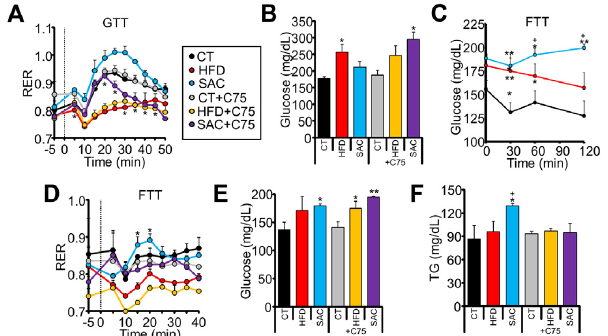
Figure 3. SAC mice rely on de novo lipogenesis (DNL) to maintain glucose homeostasis. ( A ) Oral administration of glucose increased respiratory exchange ratio (RER) in CT but not HFD mice, as measured by indirect calorimetry. SAC mice show significantly higher levels, which are reduced by pretreatment with FASN inhibitor C75. ( B ) At the end of the calorimetric test shown in ( A ), only HFD mice show high glucose levels, but after pretreatment with C75, SAC mice also show increased glycemia. ( C , D ): Oral administration of fructose increase glucose ( C ) and RER only in SAC mice ( D ), and the increased RER is blunted by pretreatment with C75. ( E , F ): At the end of the calorimetric test shown in ( D ), SAC mice show increased glycemia and triglyceridemia, whereas C75 pretreatment further increases glycemia ( E ) and decrease TG ( F ). n = 3/group ( A , B , D , F ), n = 6/group ( C ). * p < 0.05, and ** p < 0.01 with respect to the CT group. + p < 0.05 with respect to the HFD group. FTT = fructose tolerance test.